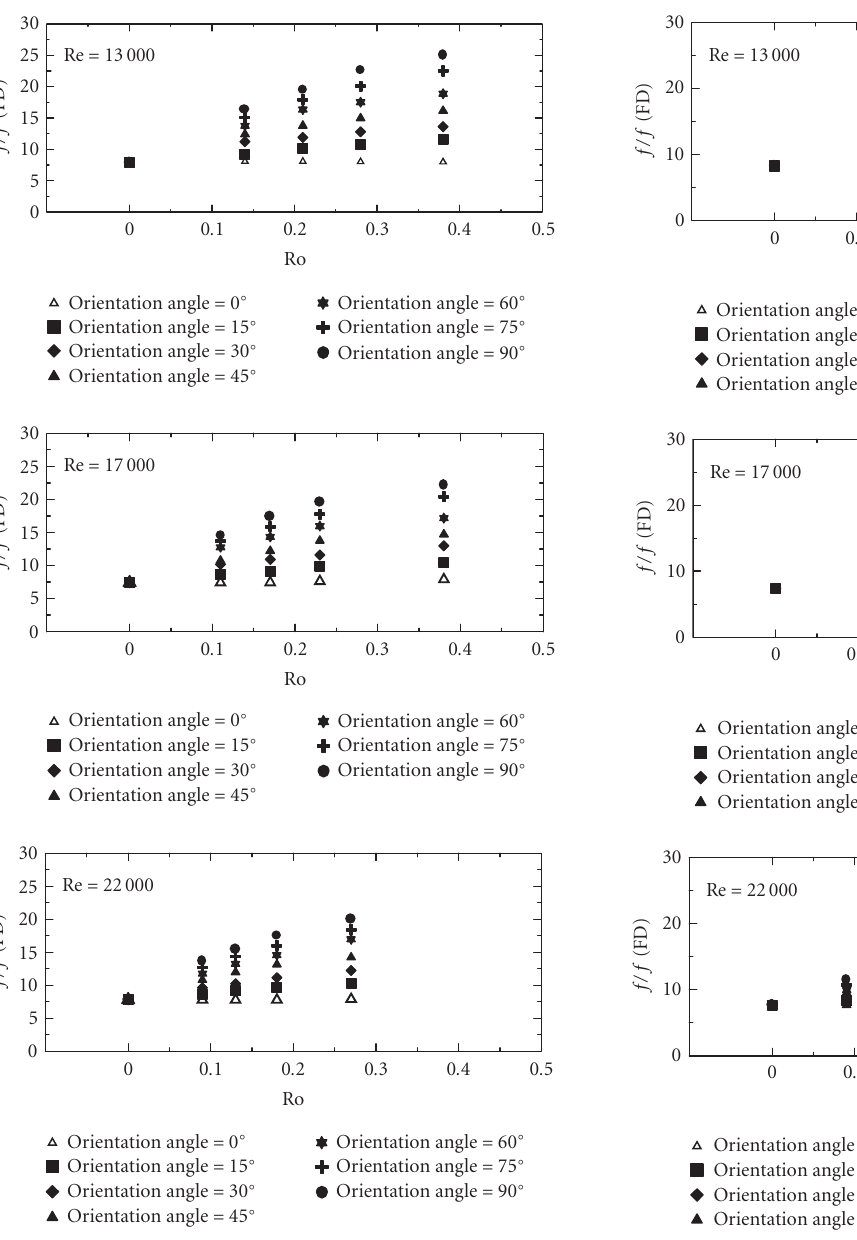
Figure 8: E ff ect of the orientation angle for 90 ◦ ribbed radial out- ward flow channel for a rib pitch-to-height ratio of 10,8.